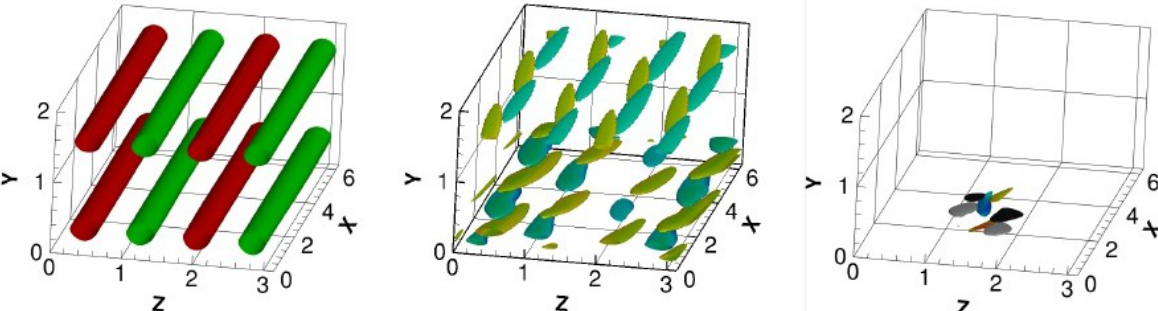
Figure 6. Different types of nonlinear optimal perturbations obtained depending on T and E 0 : the linear (black triangle in Figure 5), weakly nonlinear (black circles in Figure 5), and highly nonlinear optimal perturbations (black square in Figure 5) are represented using, respectively, for the linear optimal, iso-surfaces of the streamwise vorticity (red/green for positive/negative); for the weakly nonlinear optimal, iso-surfaces of the Q-criterion coloured in yellow/ green for positive/negative values of the streamwise vorticity; and for the highly nonlinear optimals, iso-surfaces of the streamwise vorticity (white/black for positive/negative) and of the streamwise velocity (yellow/blue for positive/negative values). On the other hand, keeping the target time as small as T = 10 and further increasing the initial energy within the range 1.25 10 − 6 < E 0 < 10 − 5 , the nonlinear optimal × perturbation changes again its main structure, localizing in the streamwise and